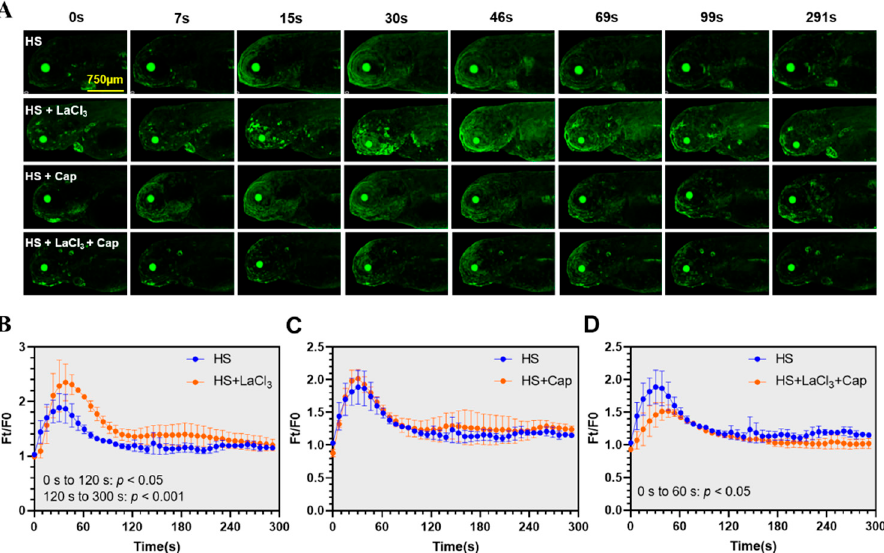
Figure 5. Effects of combining lanthanum chloride (LaCl 3 ) and capsazepine on the heat-elicited Ca 2+ events. ( A ) Fluorescence images of the transgenic zebrafish larvae pretreated with LaCl 3 and capsazepine and exposed to heat stress. The larvae were pretreated with 0.2 mM LaCl 3 (HS + LaCl 3 ), 5 μ M capsazepine (HS + Cap) or both (HS + LaCl 3 + Cap). The controls were not treated with the inhibitors (HS). ( B – D ) Line charts indicating effects of the inhibitors on heat-induced increase of Ca 2+ concentration. ( B ) LaCl 3 , ( C ) Capsazepine, ( D ) LaCl 3 + capsazepine. Data are shown as mean ± standard error ( n = 3).